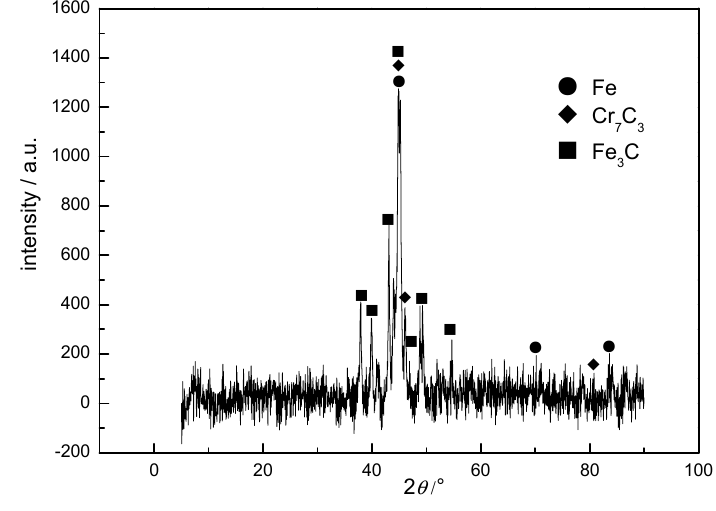
Figure 8. XRD pattern of ferroalloy.